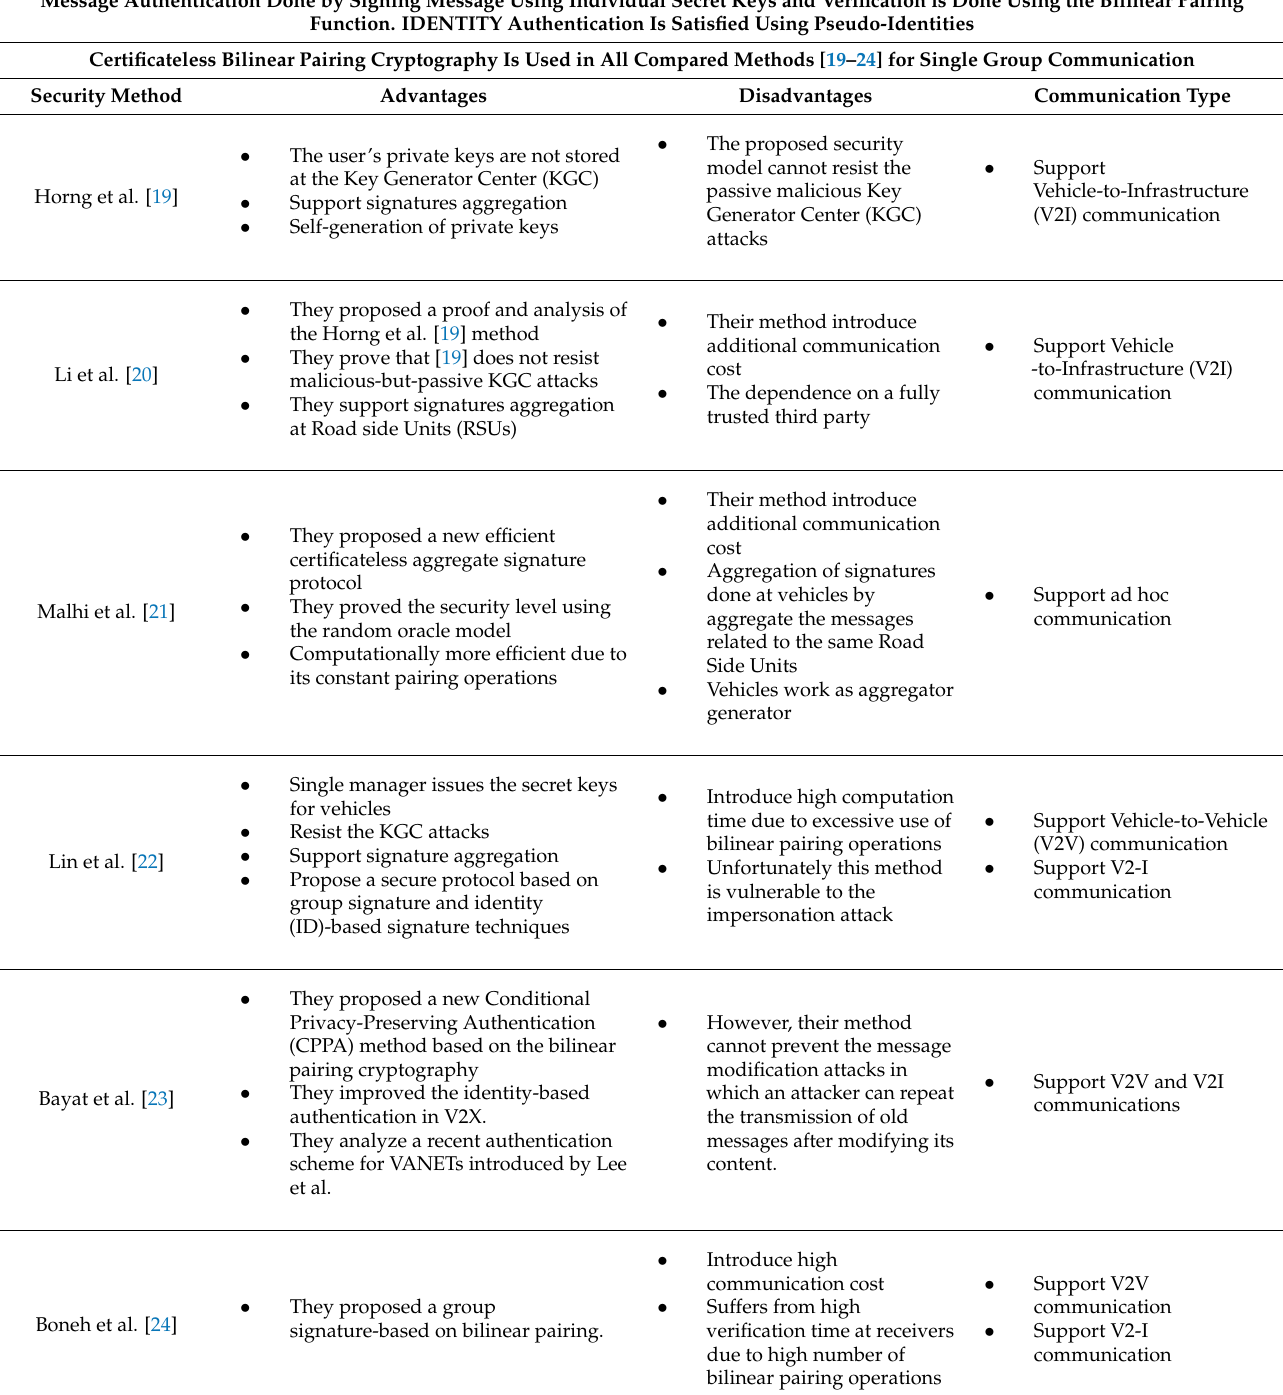
Table 1. Comparison of the previous certificateless bilinear pairing authentication